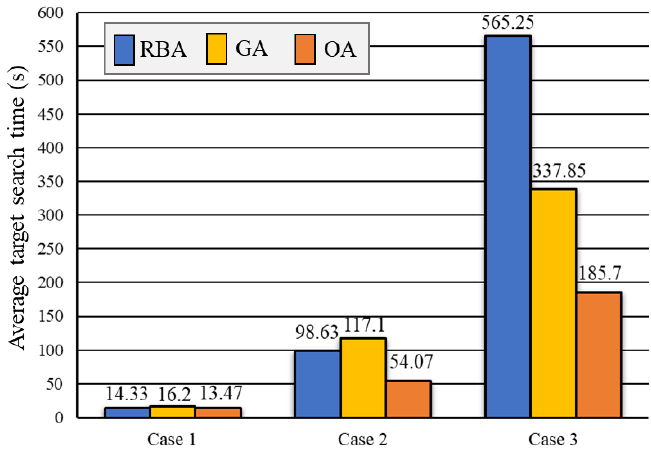
Figure 9. Average target search time for 3 cases obtained by Rule-based Algorithm (RBA), Genetic Algorithm (GA), and optimization algorithm (OA).